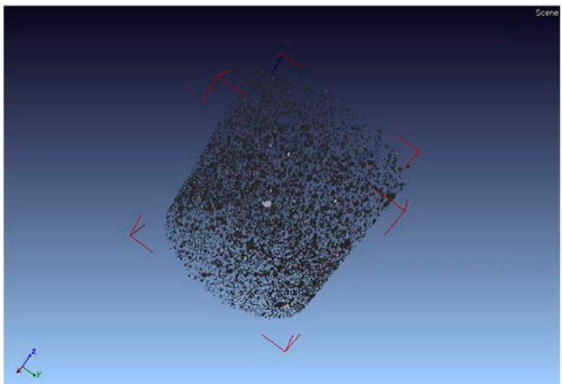
Figure 6. 3D distribution image of Na + montmorillonite particles in the bitumen.